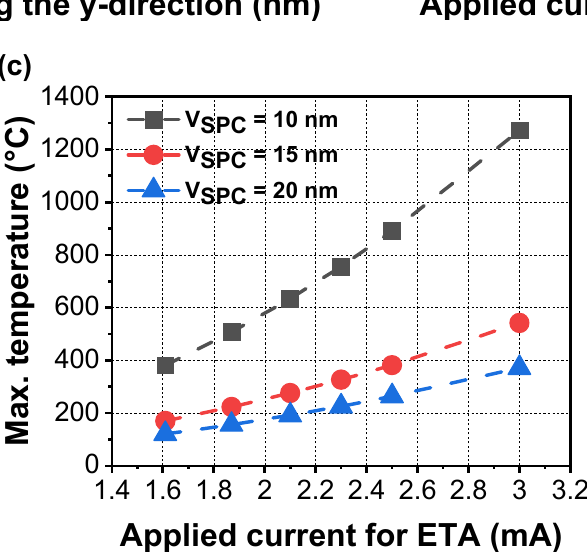
Figure 5. Extracted temperature during the ETA with various inner spacer thickness (T IN ). Distance along the y-direction (nm) T IN = 3 nm T IN = 4 nm T IN = 5 nm y